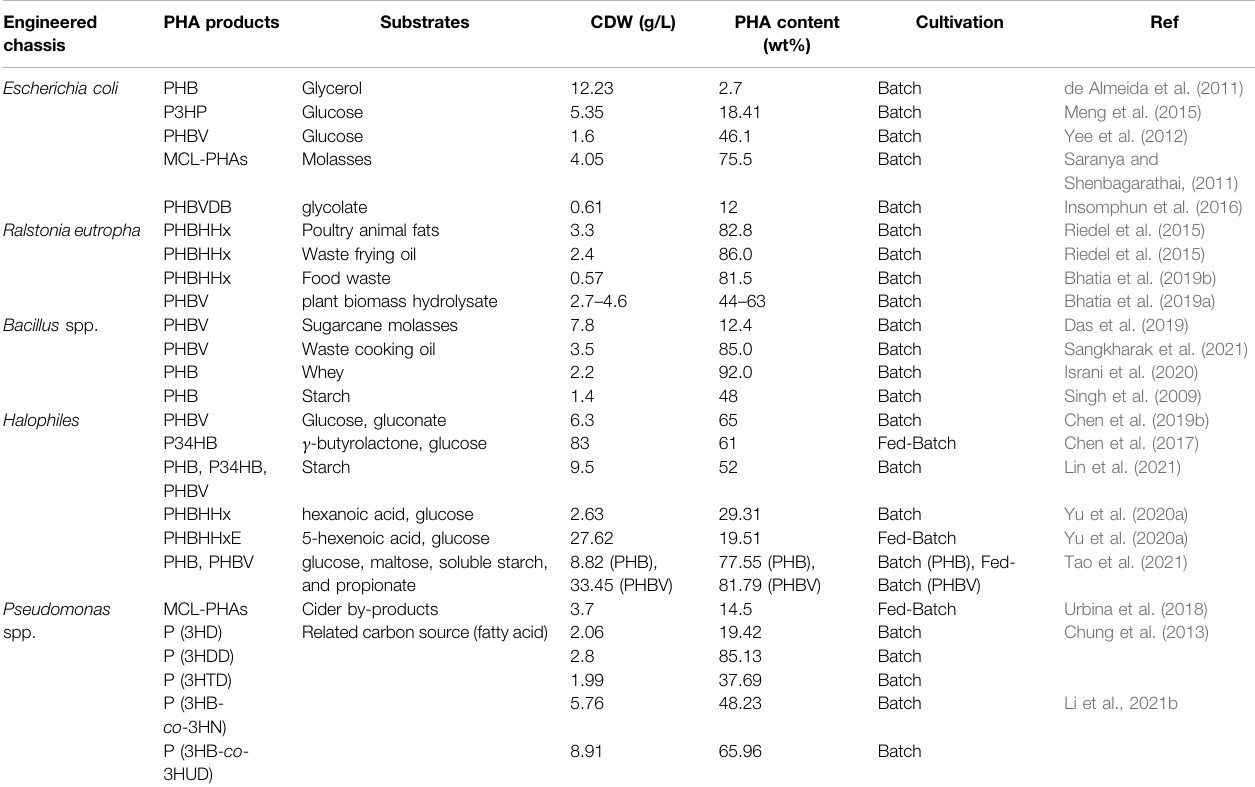
TABLE 1 | Representative production of PHA by different engineered chassis. Engineered chassis